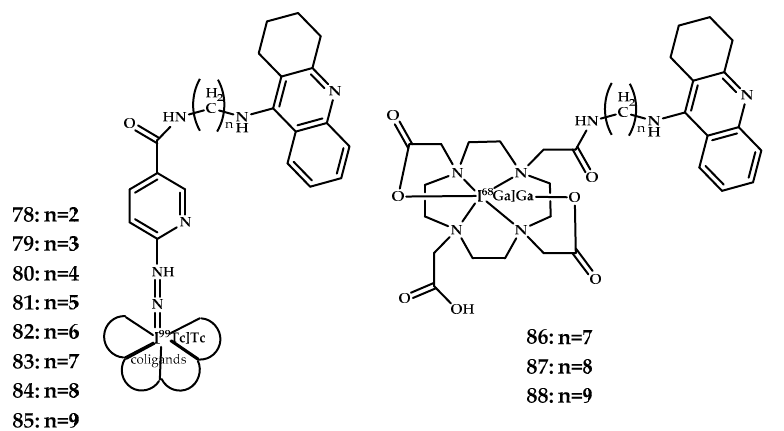
compounds 82 and 86 with the highest Log D values were selected as lead compounds.